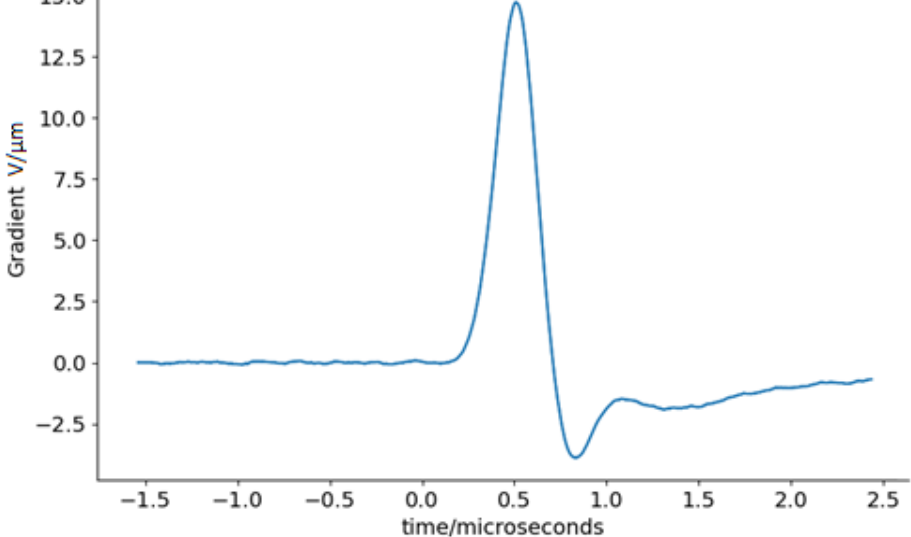
Figure 4. Voltage gradient at each point within the region of interest of Figure 3 shot 1. Dataset size = 40,000 points; range value = 200 points. A drastic decrease in the noise and a clear rising edge can be seen acting as an estimate of the maximum proton energy.